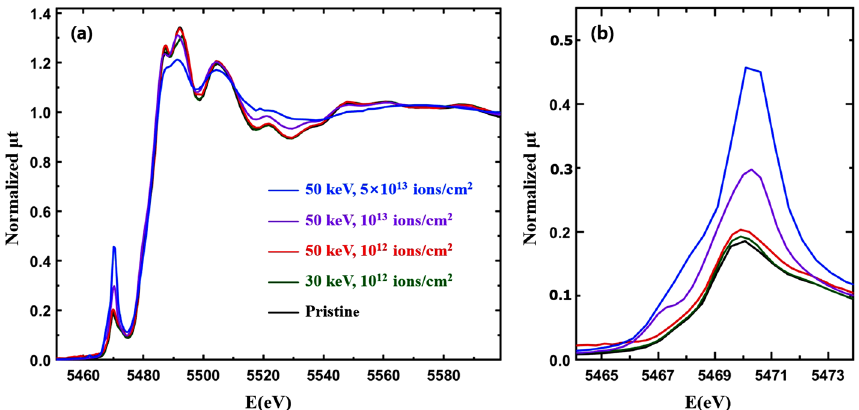
Figure 3. ( a ) Normalized total X-ray absorption (μt) for Cr-VO 2 films with different Cr energies and fluxes at the V K edge as a function of the incident X-ray energy at the room temperature. The films are the same as those used for the resistance measurements, as shown in Fig. 1, and ( b ) is a magnified image of the pre-edge peaks in ( a